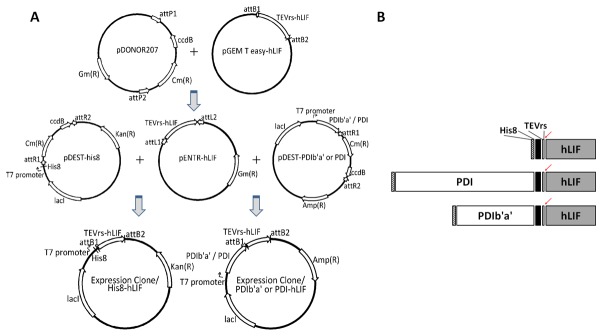
Construction and schematic representation of the His8-hLIF, PDI-hLIF, and PDIb'a'-hLIF expression vectors.(A) Vector maps of His8-hLIF, PDI-hLIF, and PDIb'a'-hLIF. Fusion protein expression in E. coli is controlled by the IPTG-inducible T7 promoter, and the selection markers for His8-hLIF for PDI-hLIF are kanamycin and ampicillin, respectively. (B) Schematic structure of the His8-hLIF, PDI-hLIF, and PDIb'a'-hLIF fusion proteins. The arrows indicate the recognition sites for the proteolytic cleavage of TEV protease. The black bars indicate the additional sequences that resulted from Gateway plasmid recombination. The lengths of each domain are scaled to the length ratio of each domain.